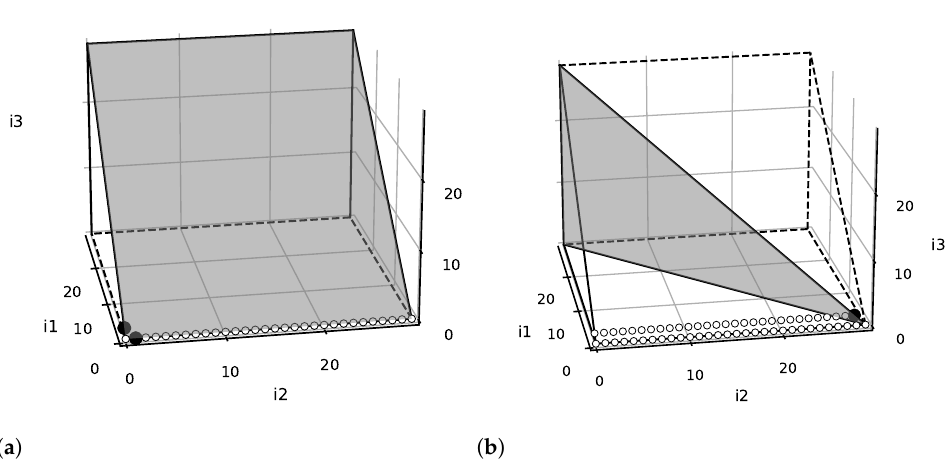
Figure 5. Evolution of predicted polyhedron faces through the reconstruction process of access A[i][k] in cholesky . Faces associated to the row of U being recalculated are shaded. Edges of the previously predicted polyhedron are dashed. Iteration points already discovered are hollow. Points used to build matrix i during the calculation of the face are marked in